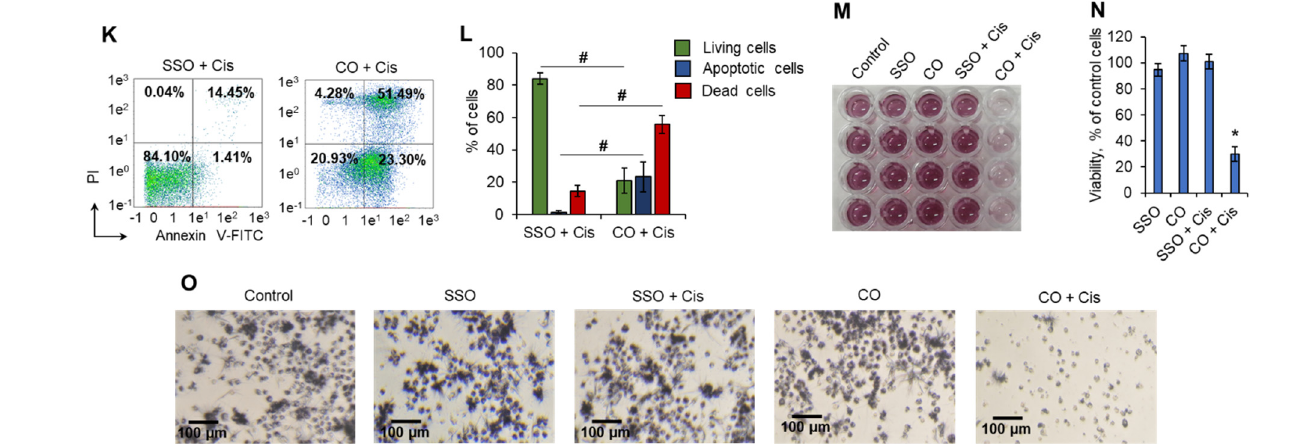
Figure 7. Modulation of RAD51A alternative splicing results in CD4 + T cell protection against cisplatin-induced apoptosis. Transfection efficiency of CD4 + T cells. Representative flow cytometry plots of cells transfected with Cy5.5-labeled ( A ) SSO for RAD51A or ( B ) a control 26-mer oligonu- cleotide 72 h posttransfection. ( C ) Efficiency of transfection. ( D ) Mean fluorescence intensity (MFI) of Cy5.5-positive cells. ( E ) mRNA levels of RAD51A measured by real-time RT-PCR in transfected CD4 + T lymphocytes incubated with cisplatin. mRNA levels were normalized relative to the expression of the reference gene 18S. ( F ) Western blotting for RAD51 protein and the reference protein GAPDH in transfected cells incubated with cisplatin. ( G ) Results of RAD51 protein quantification relative to GAPDH. ( H ) mRNA levels of RAD51A splice variants measured by real-time RT-PCR in CD4 + T cells. ( I ) Representative TUNEL flow cytometry diagrams for cells transfected with oligonucleotides and incubated with cisplatin. ( J ) Results of TUNEL assay for flow cytometry. ( K ) Representative flow cytometry plots for cells labeled with annexin V-FITC and propidium iodide after transfection with oligonucleotides and incubation with cisplatin. The proportions of live cells (low left quadrants), apoptotic cells (low right quadrants), and dead cells (two upper quadrants) are presented. ( L ) His- tograms of live, apoptotic, and dead cells measured by flow cytometry. ( M ) Representative photo of the MTT test for transfected CD4 + T lymphocytes incubated with cisplatin. ( N ) Results of MTT test quantification. ( O ) Bright-field optical images of the MTT test for transfected CD4 + T cells exposed to Cis. AU: arbitrary units; Cis: cisplatin; CO: control nonspecific oligonucleotide; FL: full-length splice variant. SSO: splice-switching oligonucleotide. ∆ 4: mRNA splice variant with the deletion of exon 4. ∆ 9: mRNA splice variant with the deletion of exon 9. n = 4. * p ≤ 0.05 vs. initial nontransfected cells. # p ≤